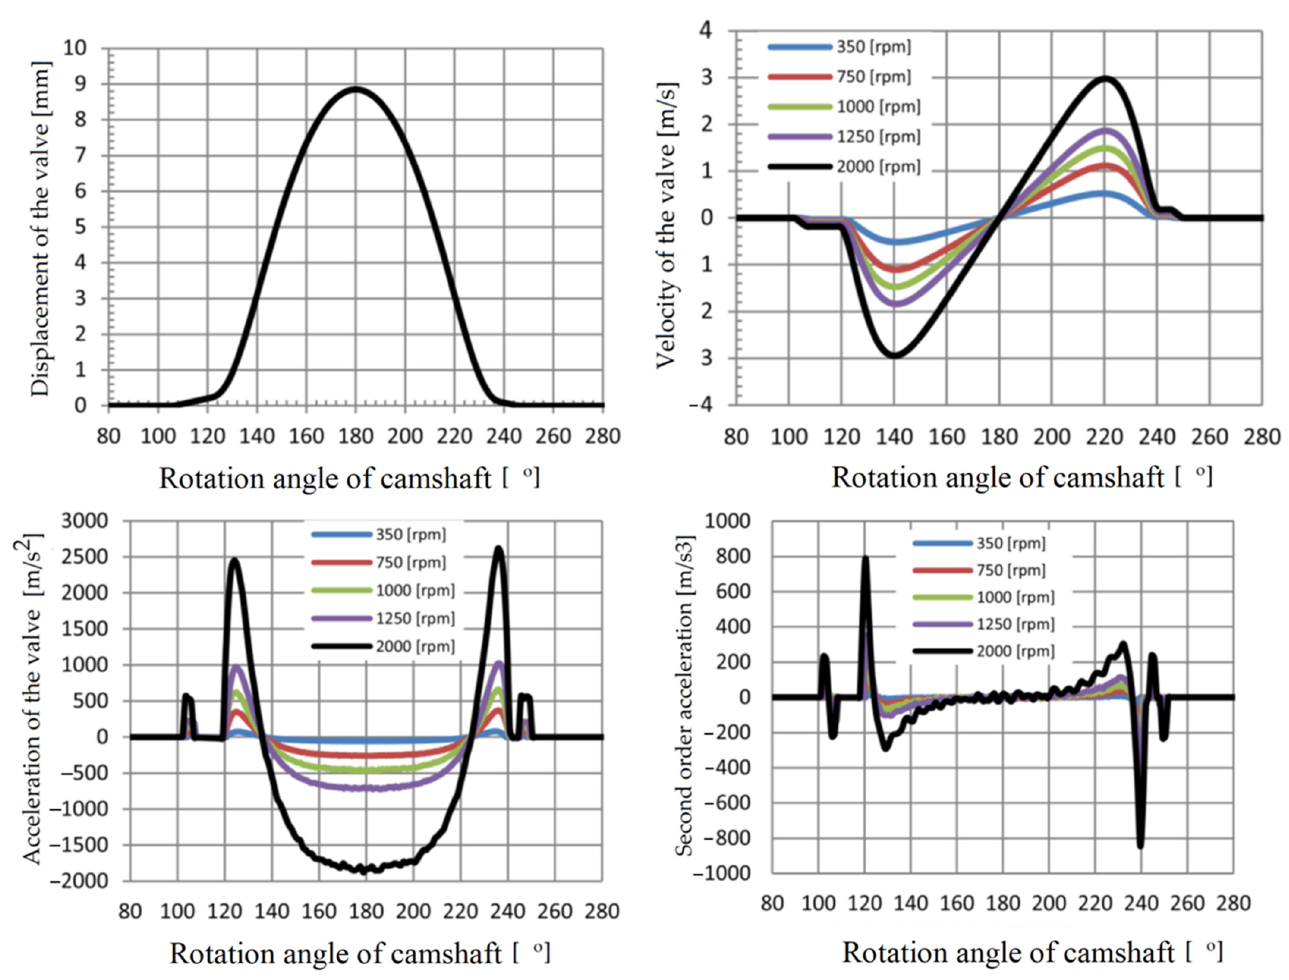
Figure 10. The kinematic behaviour of the valve at different speeds.